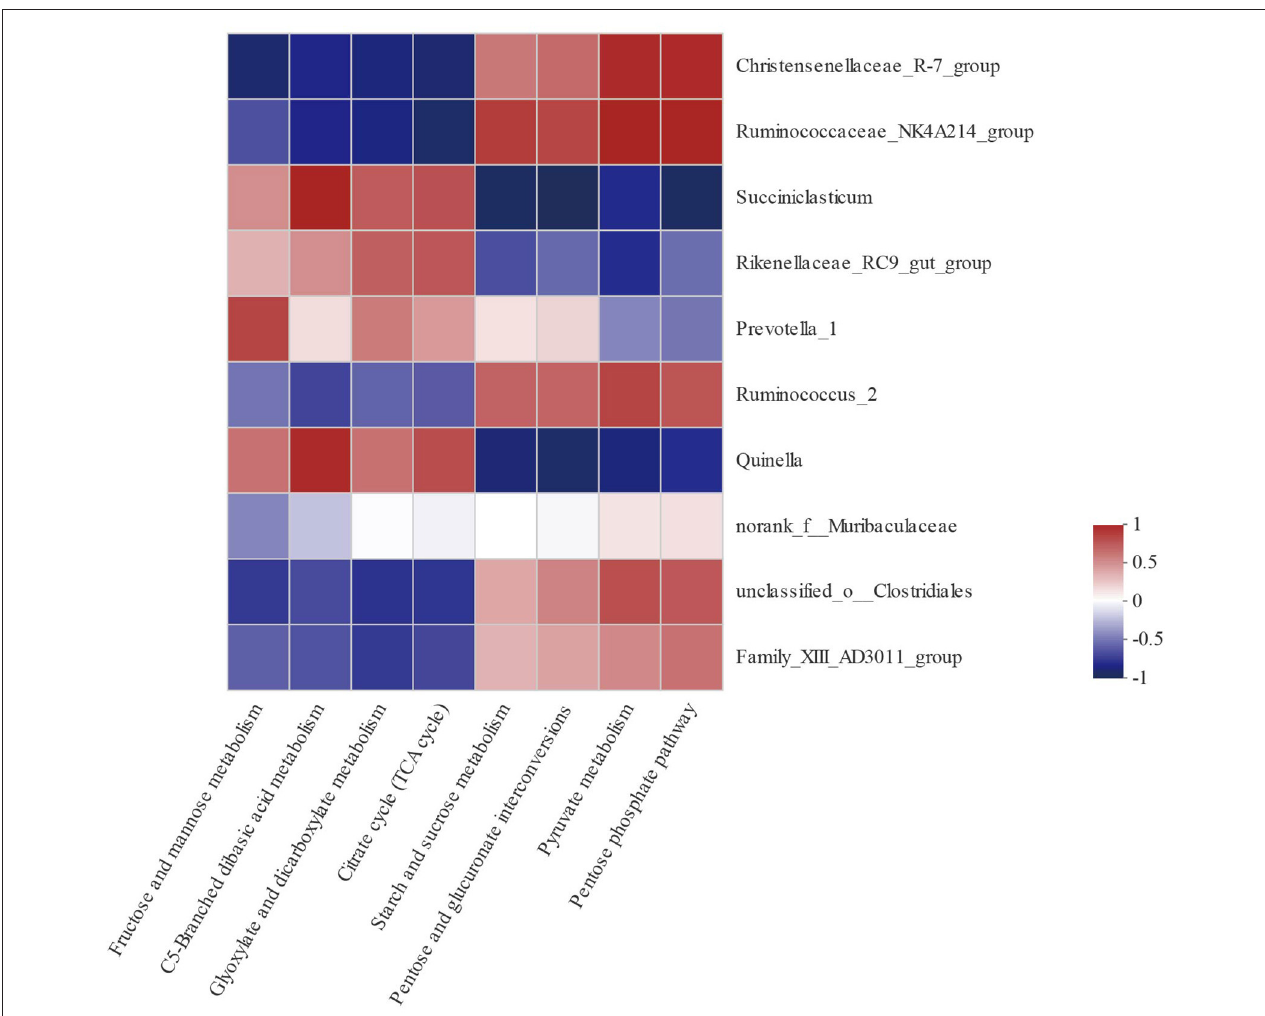
FIGURE 5 | Correlation analyses between the 10 most relatively abundant bacterial genera and altered carbohydrate metabolic pathway. The blue represents a negative correlation between the abundance of the species and the metabolic pathways, the red color represents a positive correlation, and the white shows that the correlation was not